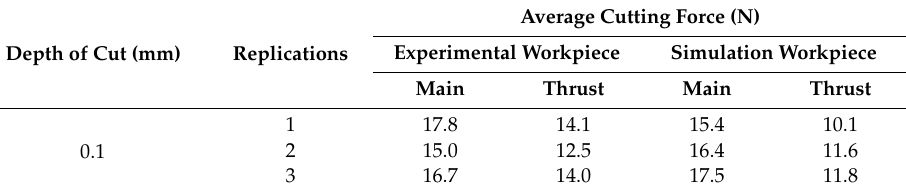
Figure 3. ( a ) DEM model of the cutting simulation and recorded forces, ( b ) optical images of the machined area of the soda-lime glass sample and recorded forces. Table 4. Average cutting forces for each experiment.